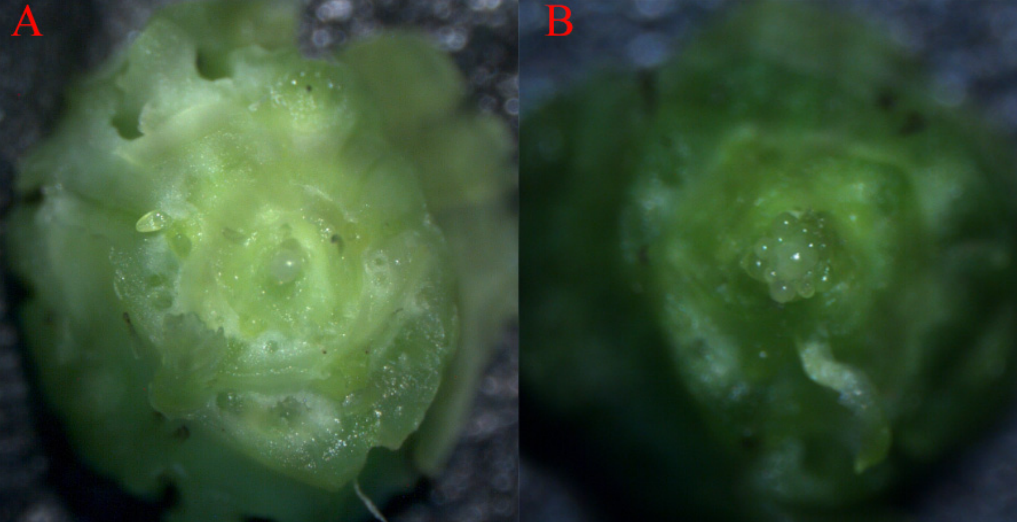
Figure 2. The optical microscope observation of shoot apical meristem (SAM) of rapeseed. ( A ) Veg- etative stage as the finger-like leaf primordia around the SAM; ( B ) Floral initiation stage, as the dome-like floral primordia around the SAM.